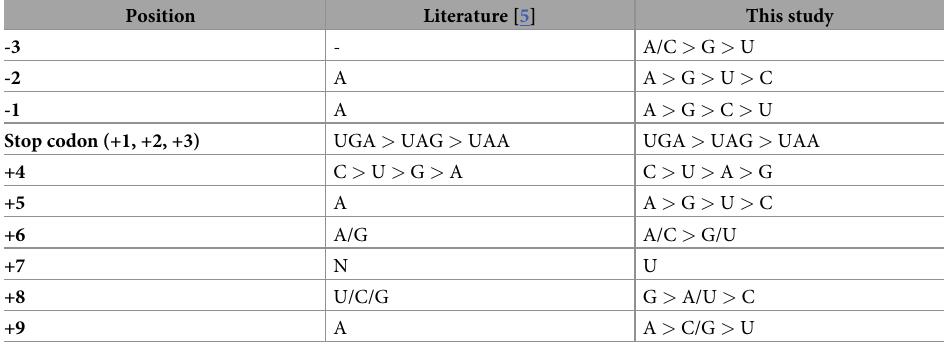
Table 2. Comparison of nt -3 to +9 effects (based on Figs 5 and 6) to previous data [5]. The order of nucleotide/ stop codon is from most to (“ > ”) least permissive to readthrough. Position Literature [5] This